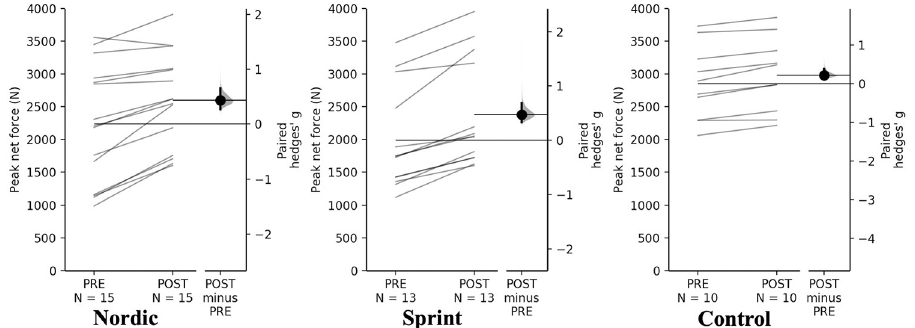
Fig 8. Gardner-Altman estimation plots identifying Pre- and Post-intervention individual changes for peak net force and Hedge’s g effect size with the 95% CI indicated by the ends of the vertical error bar.